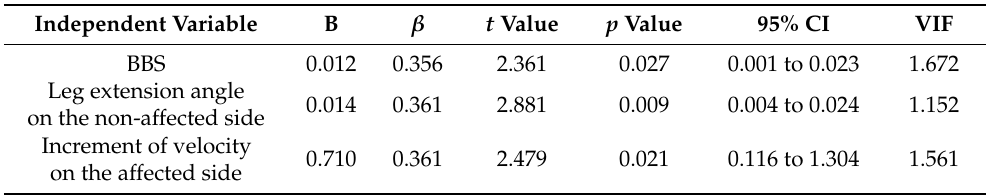
Table A1. Dependent variable: Gait speed. Independent variable: BBS, FMA-LL, MI-LL, leg extension angle, and increment of velocity on affected and non-affected sides.